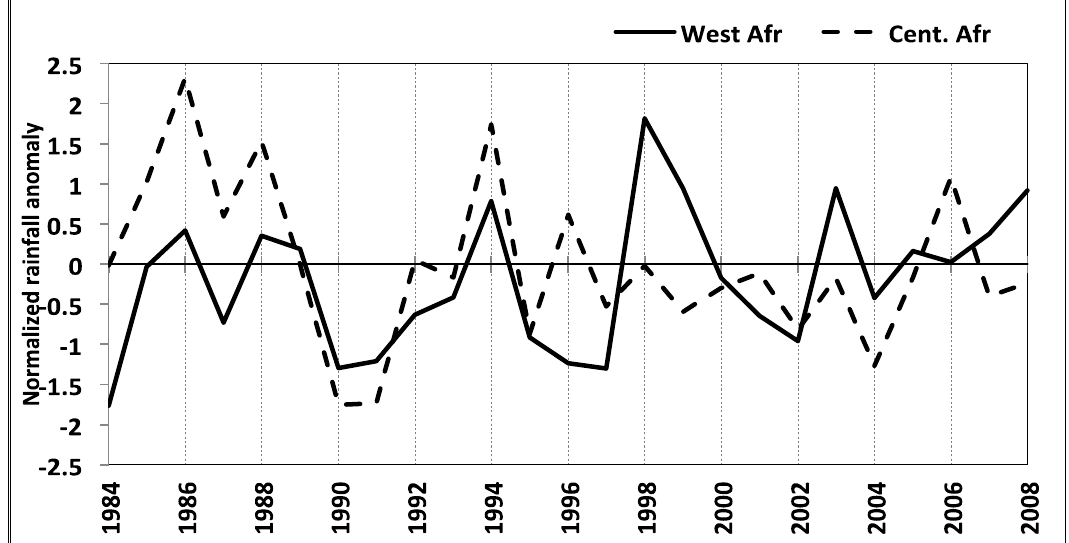
Figure 2. Year-to-year July to September normalized rainfall anomalies for West Africa (10°–15° N, 15° W–10° E; solid lines; mean rainfall = 5.2 mm d − 1 ; σ = 0.68 mm d − 1 ) and Central Africa (7.5°–12.5° N, 10–30° E; dashed lines; mean rainfall = 5.7 mm d − 1 ; σ = 0.54 mm d − 1 ). Anomalies are departures from the mean and normalized by the respective standard deviation.